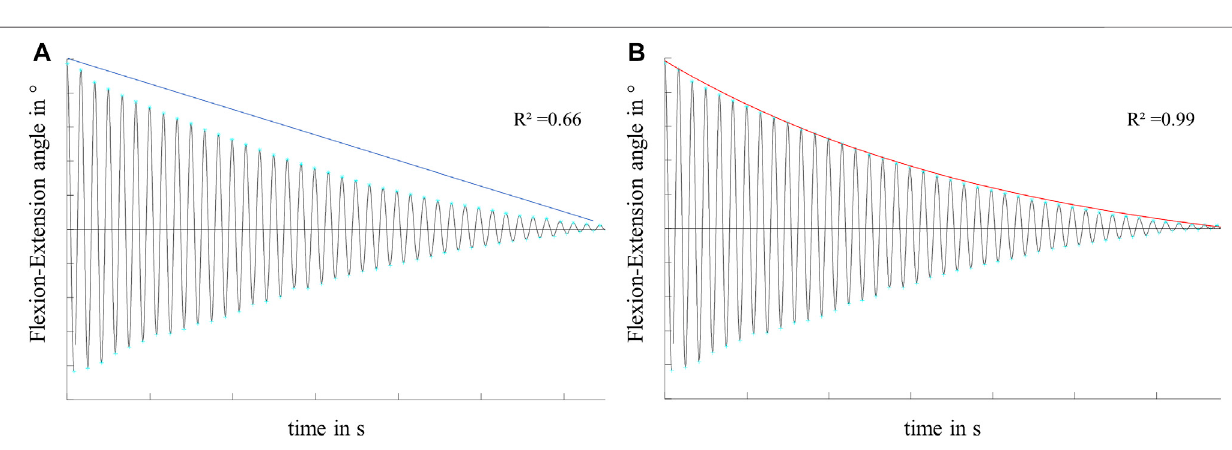
models to the recorded fl exion-extension data. The radius of a medial ovine femoral condyle (r) was determined using a set of isotropic computer tomography scans, resulting in r (cid:1) 15 mm. The distance between the pendulum center of mass and the rotation axis (L) was measured for each individual